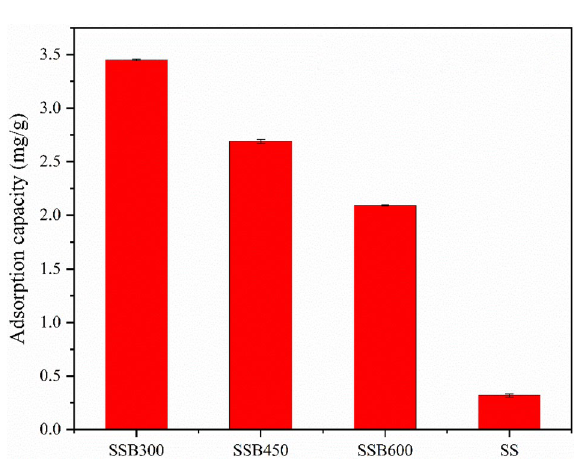
Figure 3. The adsorption capacity of biochar and sorghum straw for ammonium at different carbonization